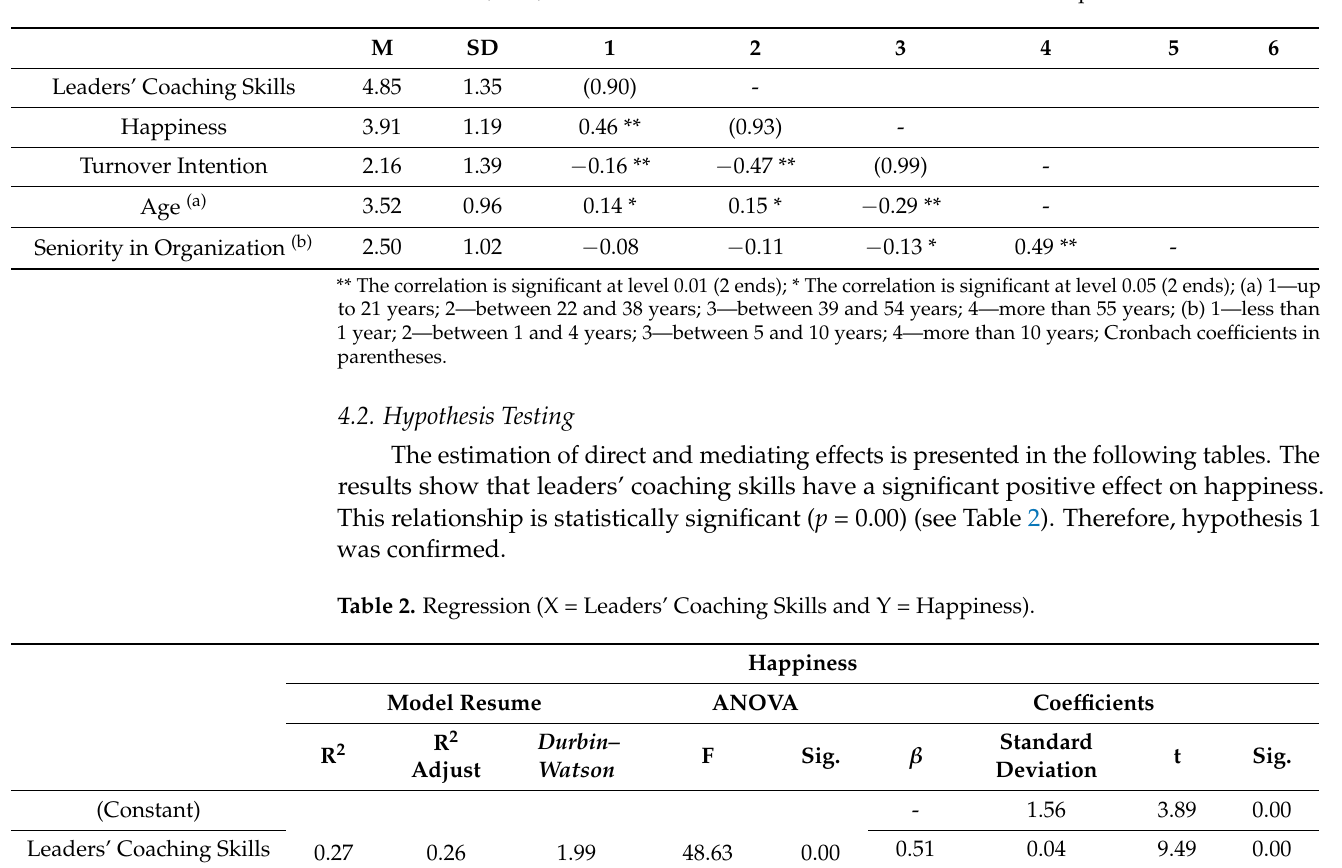
Table 1. Means, SDs, and correlations between variables and Cronbach’s alpha.